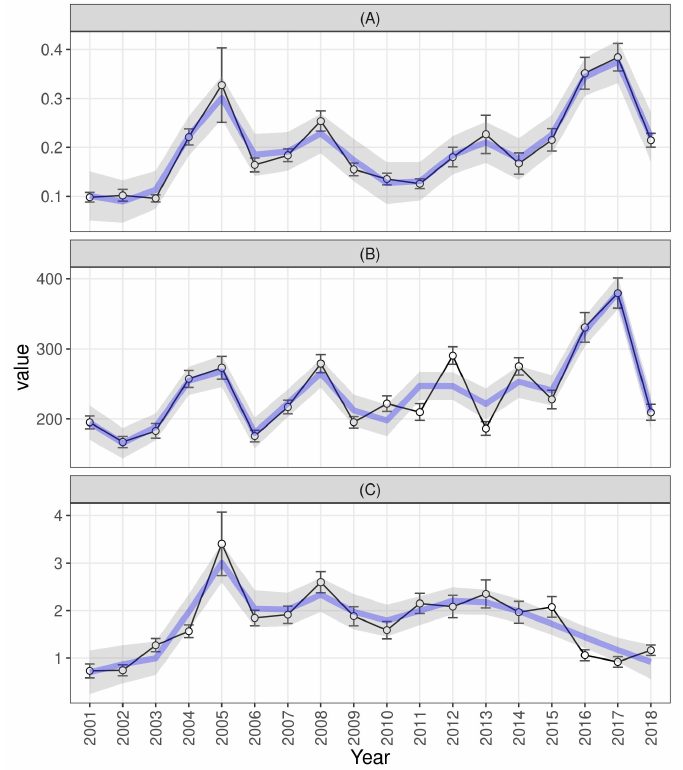
Figure 7 – Yearly averages per 100 km 2 of (A) Forest loss area (in km 2 ) of large clearings (>1 ha in size); (B) Number of small clearings (<1 ha in size); (C) Number of fire points remotely sensed by the MODIS sensor in or around forest loss patches